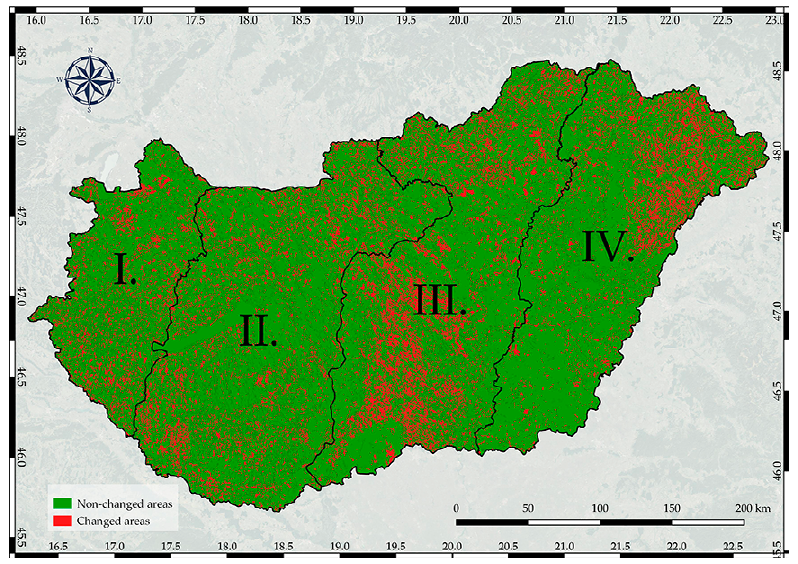
Figure 4. The four zone and the changed/non-changed